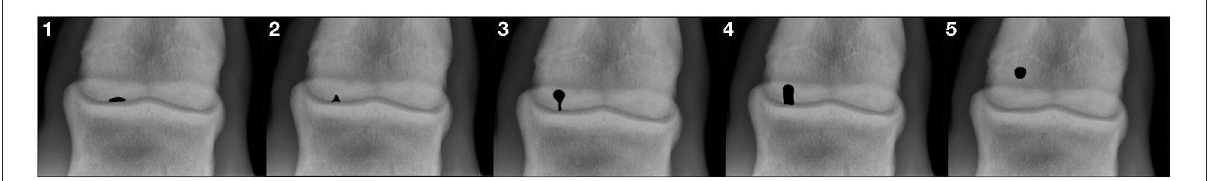
FIGURE5 Categorization of subchondral lucency subtypes: (1) Well defined shallow dome shaped subchondral defect ( < 3mm height), (2) Short well defined triangular or fissure-like defects ( < 3mm height and width), (3) Lollipop or mushroom shape, round or oval cystic lucency extending to the articular surface, with narrow cloaca, (4) Columnar shape extending to a large articular surface deficit and (5) Lucency without an articular deficit and no radiographic evidence of a cloaca in the subchondral bone plate.